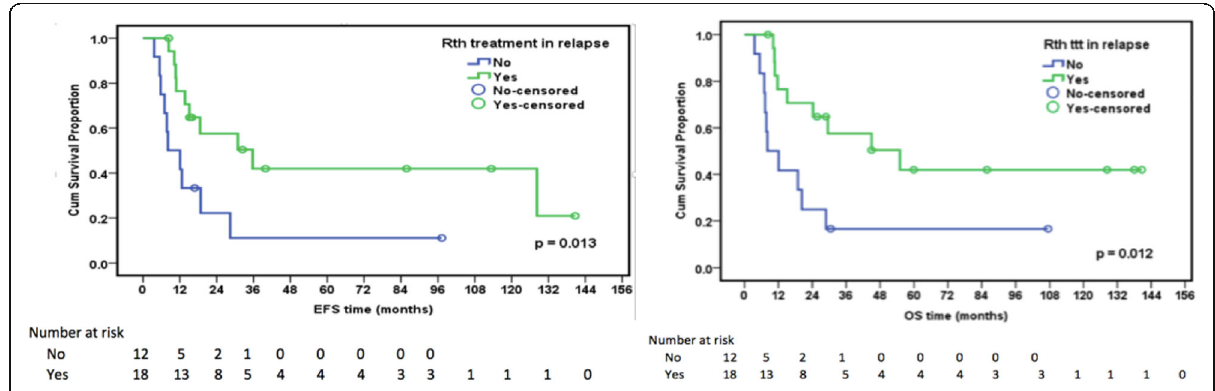
Fig. 2 Impact of radiotherapy on survival outcome among relapsed Wilms ’ tumor